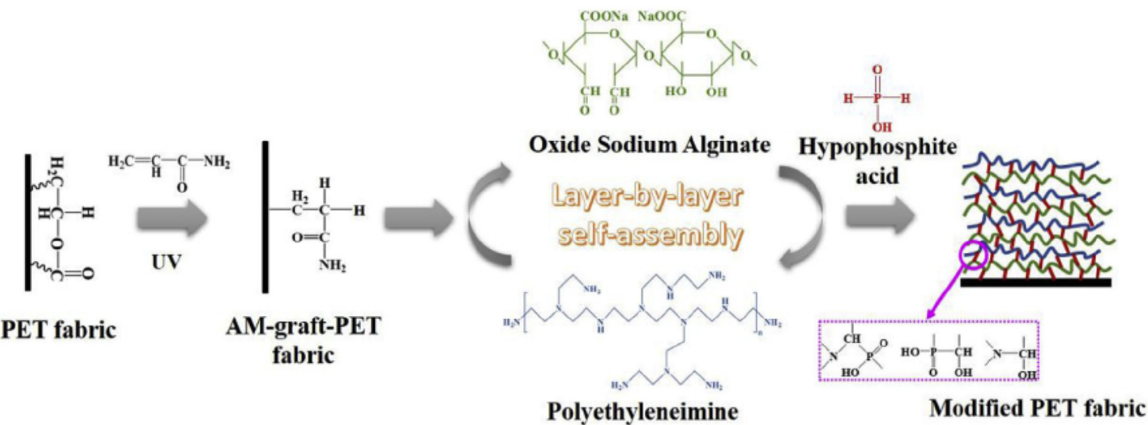
Figure 6. Schematic of LbL deposition of pre-treated MA-graft-polyester (PET) fabric coated with 15 BLs of OSA/PEI and post-treated with HA cross-linking [130] Reproduced with permission from Pan, Y.; Liu, L.; Song, L.; Hu, Y.; Wang, W.; Zhao, H., Polym. Degrad. Stab.; published by Elsevier Ltd., 2019.